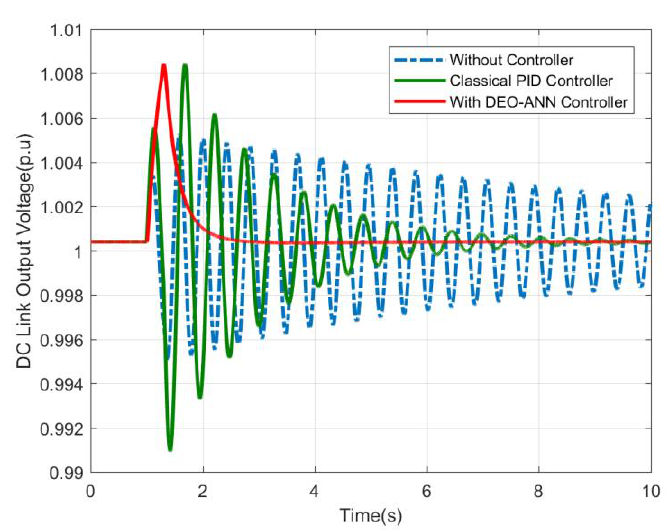
Figure 16. PV output current.